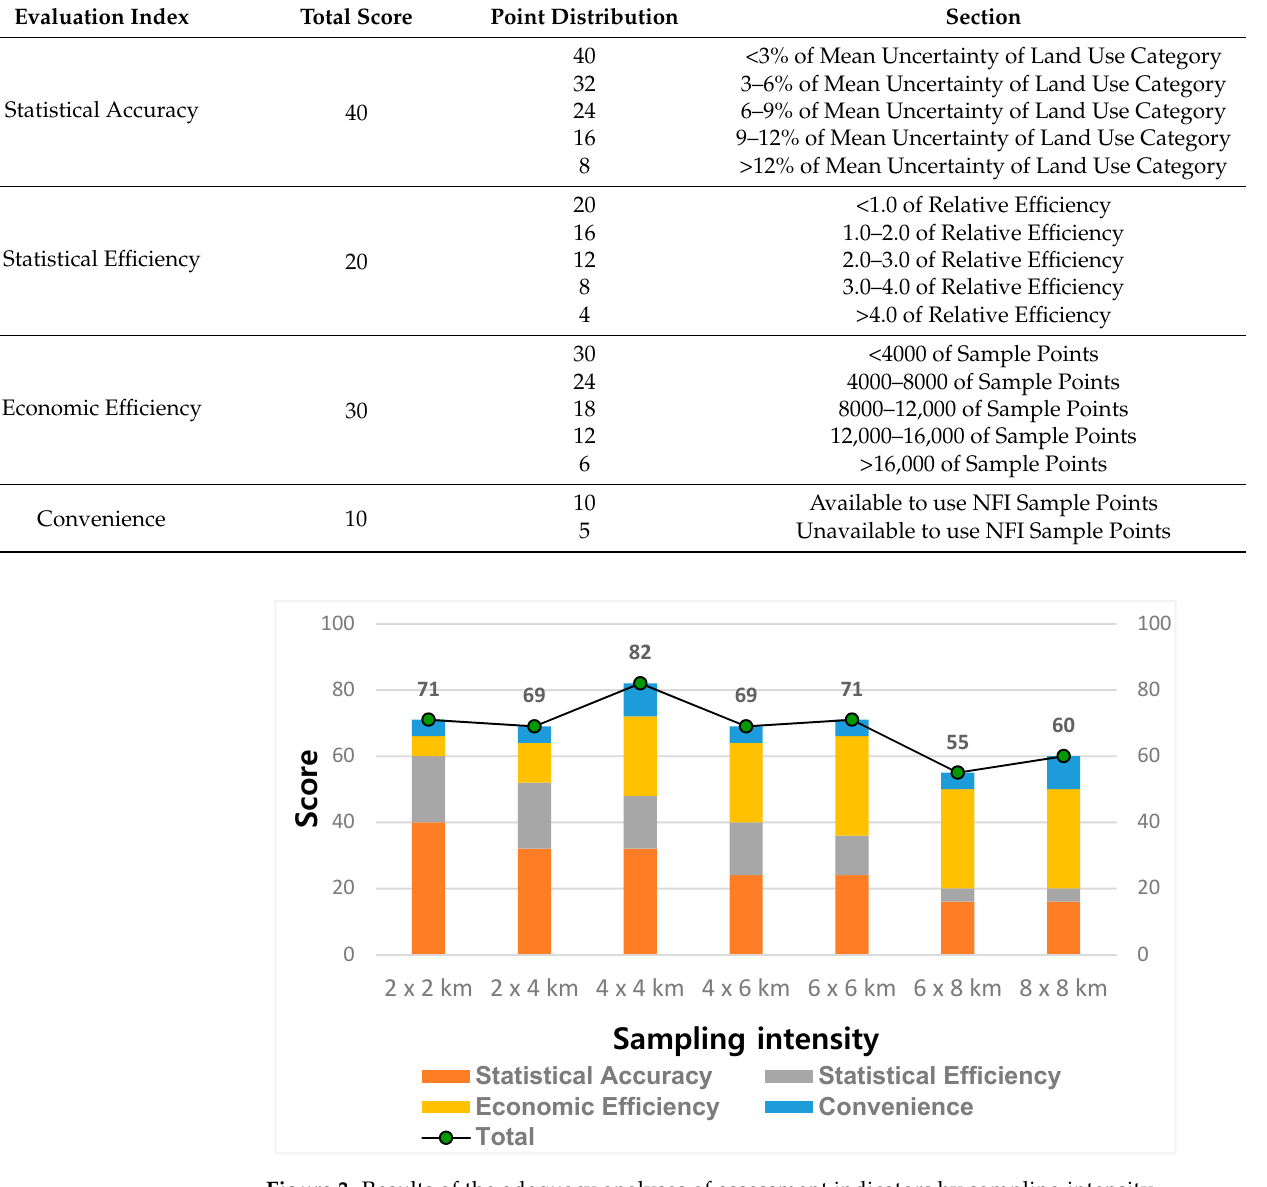
Figure 3. Results of the adequacy analyses of assessment indicators by sampling intensity.